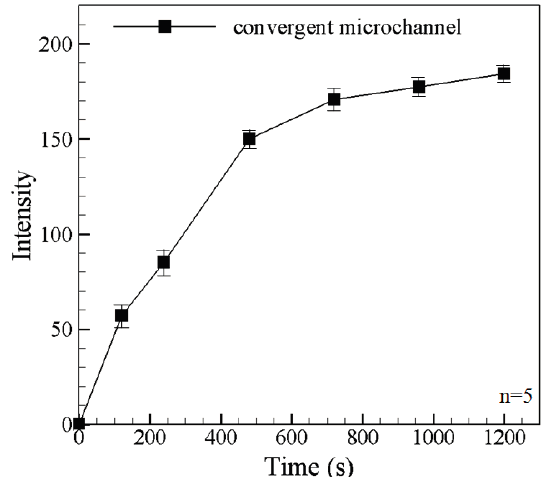
Figure 4. Fluorescence intensity curves of the concentrated BSA under a voltage of 100 V in the nano-microfuidic chips with convergent microchannel. Data points represent the mean of five measurements, and the error bars represent one standard deviation from the